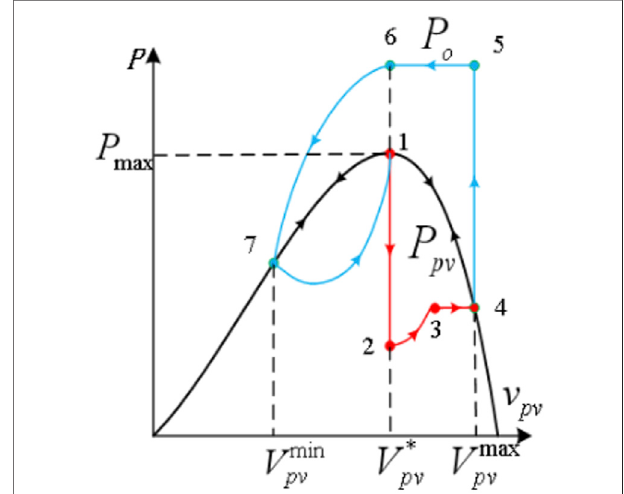
FIGURE 6 | Power – voltage evolution curve of the PV generator and the DC distribution network during the transient voltage sag and the recovery